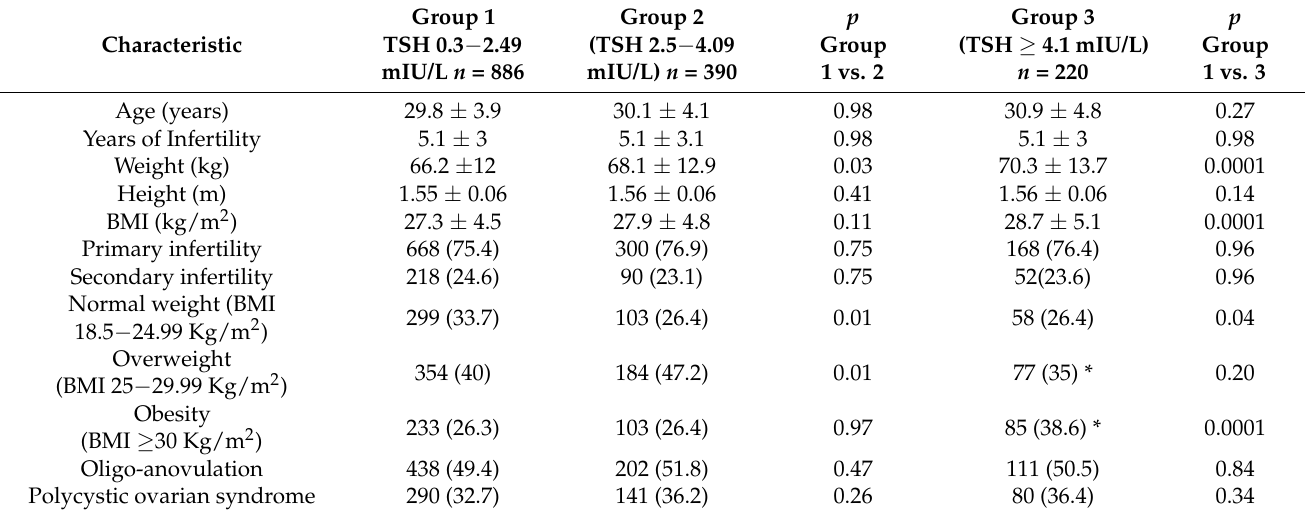
Table 2. Clinical characteristics of infertile Mexican women with and without subclinical hypothyroidism using two cut-offs for